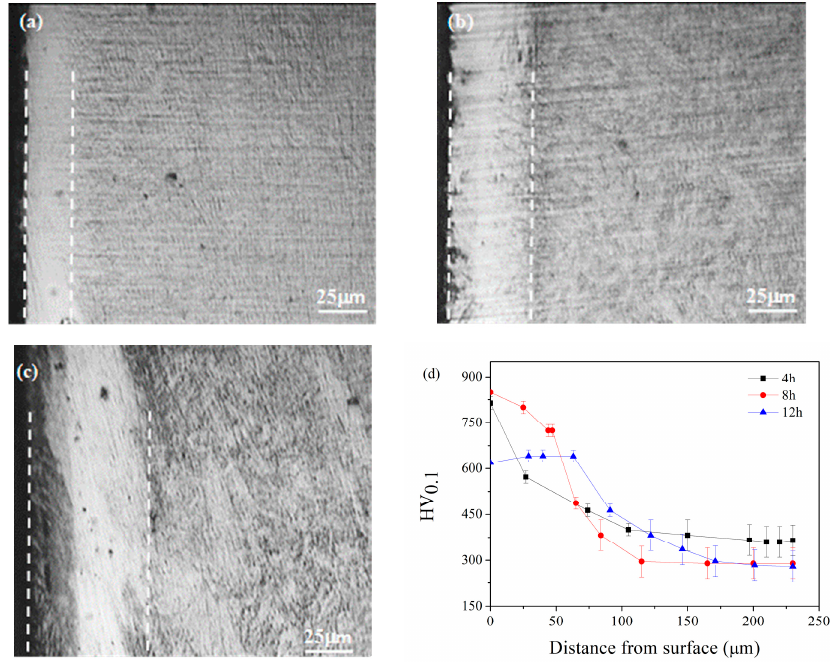
Figure 2. ( a – c ) Cross section microstructures. ( d ) Microhardness profiles of AISI 420 stainless steel plasma carburized at 460 °C for 4, 8, and 12 h.